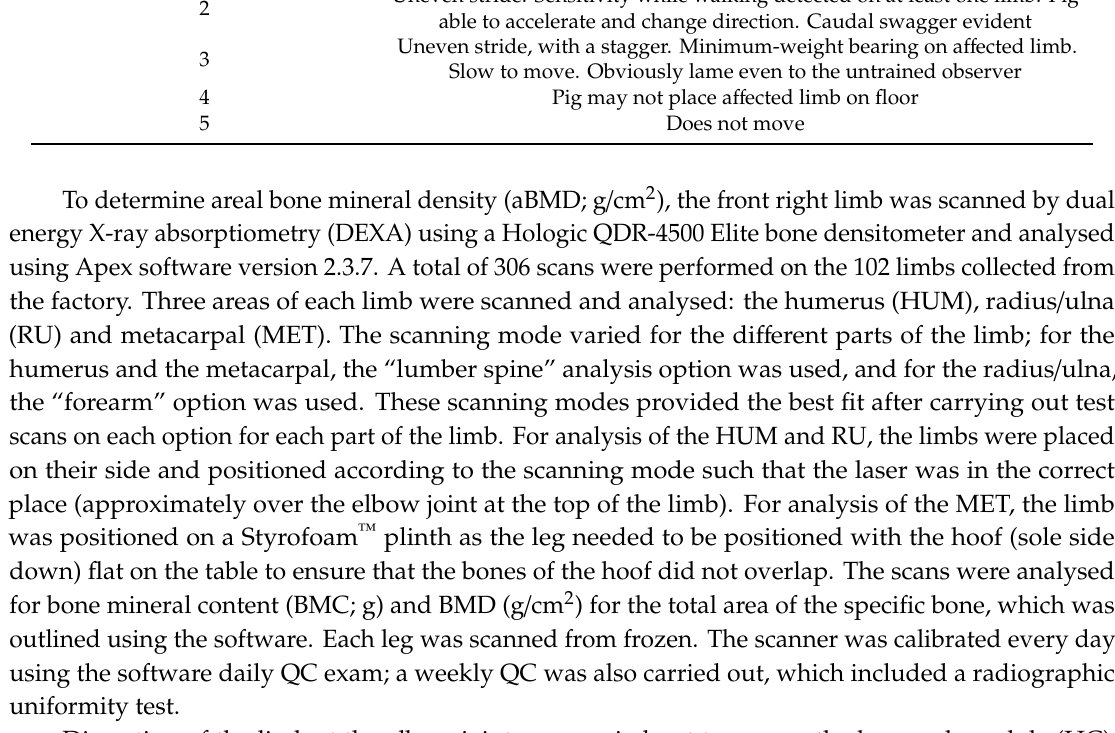
Table 3. Scoring system for locomotory ability (adapted from Calderon-Diaz [23]). Score Description 0 Even strides. Pig is able to accelerate and change direction rapidly Pig appears sti ff . Abnormal stride, which isn’t easily identified. Movements 1 no longer fluid but pig still able to accelerate and change direction rapidly. Caudal swagger evident. Uneven stride. Sensitivity while walking detected on at least one limb. Pig able to accelerate and change direction. Caudal swagger evident Uneven stride, with a stagger. Minimum-weight bearing on a ff ected limb. Slow to move. Obviously lame even to the untrained observer Pig may not place a ff ected limb on floor Does not